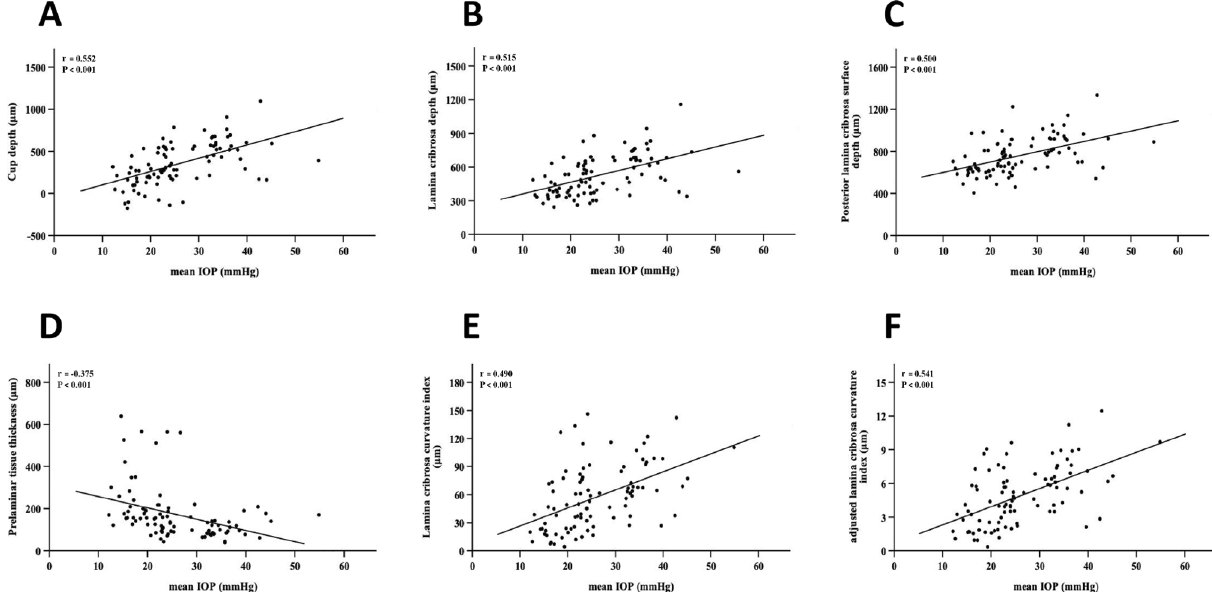
Figure 3. Linear regression analysis between different IOP levels and related parameters of lamina cribrosa. ( A – F ) showed the linear correlation between different IOP levels and CD, LCD, PLCSD, PTT, LCCI and aLCCI, respectively. The results show that there is a significant linear relationship between different IOP levels and these six parameters (P < 0.001), and the IOP level is positively correlated with the changes of CD, LCD, PLCSD, LCCI and aLCCI, but negatively correlated with